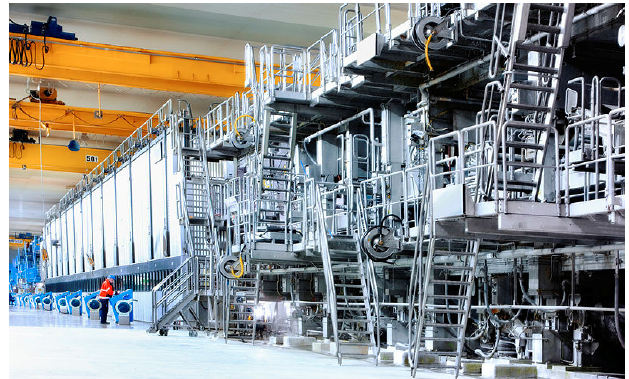
Figure 3. A paperboard machine at the Iggesund paperboard mill.